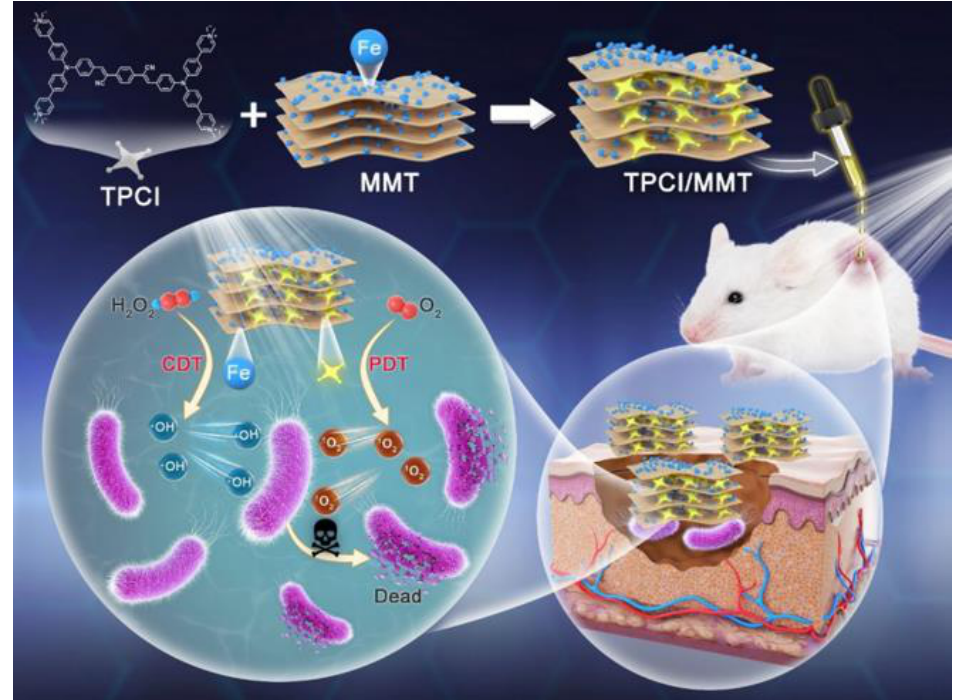
Figure 9. Molecular structure of TPCI and schematic illustration of the synergistic PDT-CDT based on TPCI/MMT for efficient eradication of bacterial. Reprinted with permission from [107].